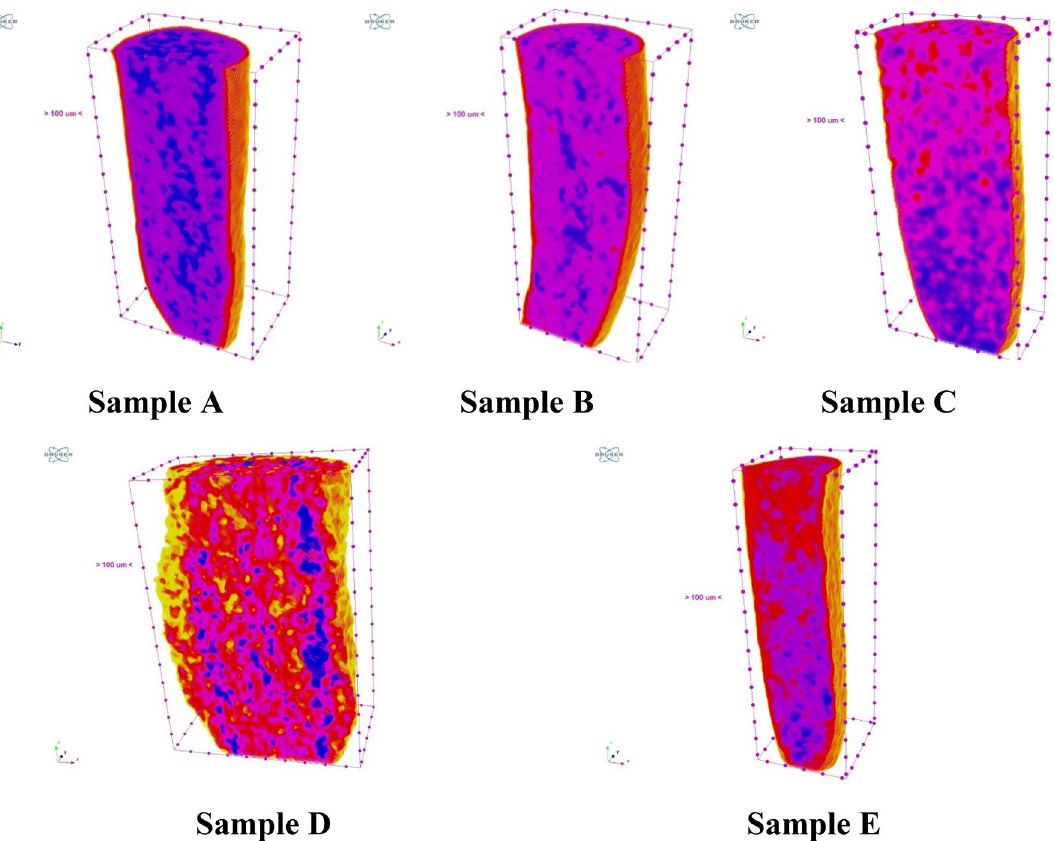
Figure 13. 3D visualization with color identification of the X-ray density of the roots